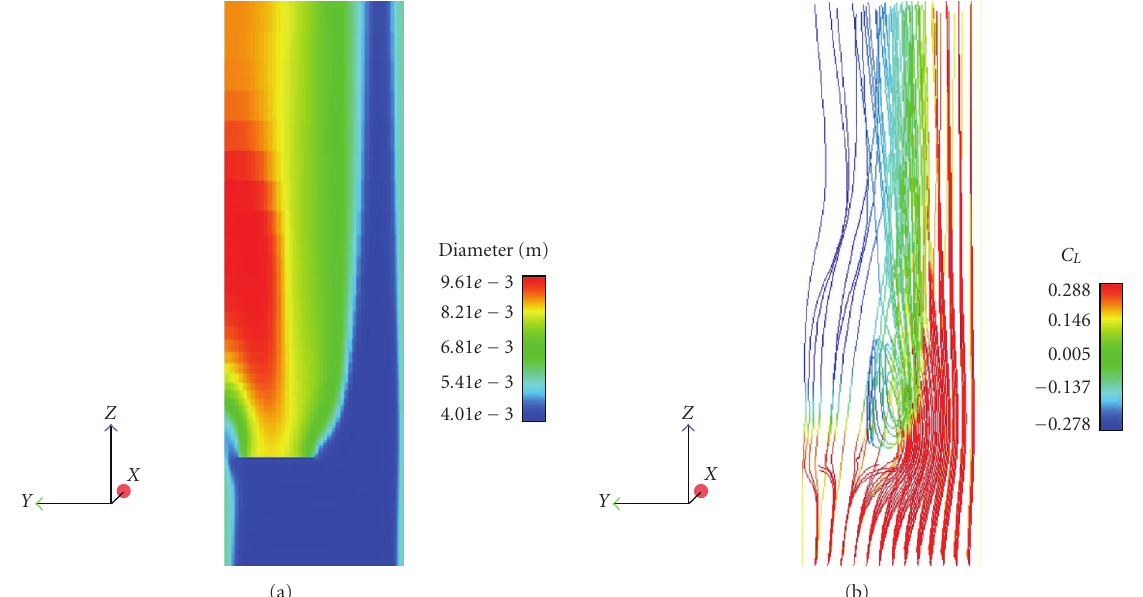
Figure 14: Neptune CFD numerical results for local mean bubble diameter and corresponding streamlines colored by the equivalent mean lift coe ffi cient (run 074) ( F B = 0; F C = 1).